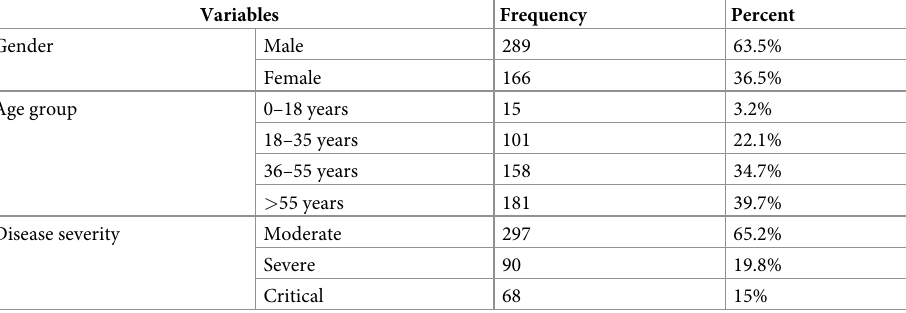
Table 1. Socio-demographic characteristics of study